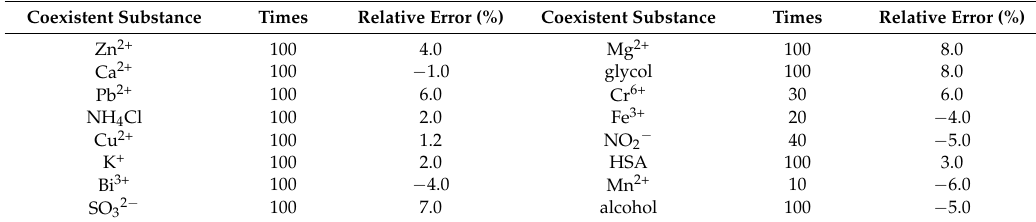
Table 2. Effect of coexistence substances.